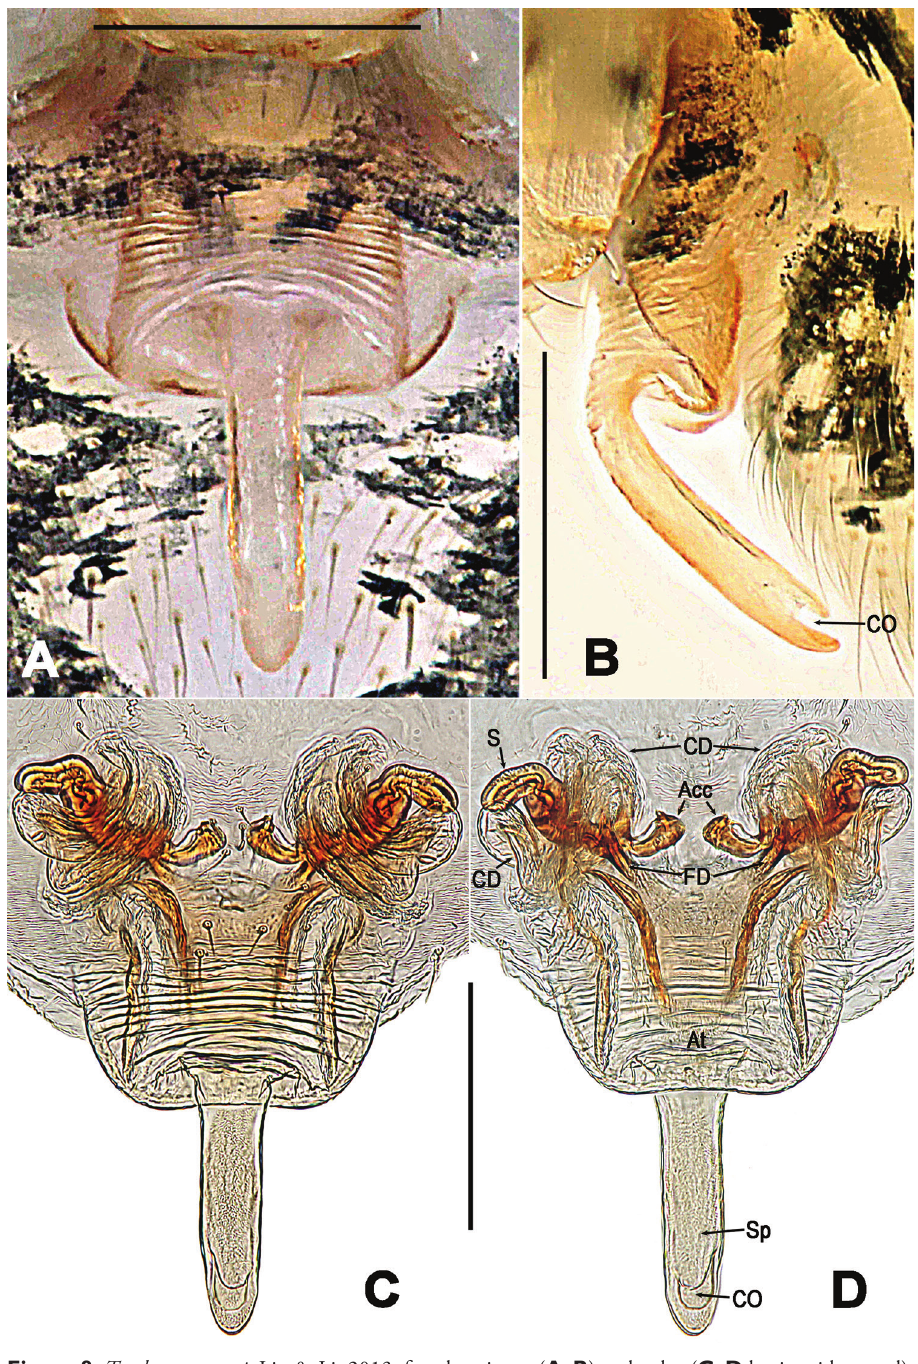
Figure 8. Trogloneta yuensis Lin & Li, 2013, female epigyne ( A, B ) and vulva ( C, D lactic acid-treated). A, C ventral B lateral D dorsal. Abbreviations: Acc accessory gland; At atrium; CD copulatory ducts; CO copulatory opening; FD fertilisation ducts; S spermathecae; Sp scape. Scale bars: 0.20